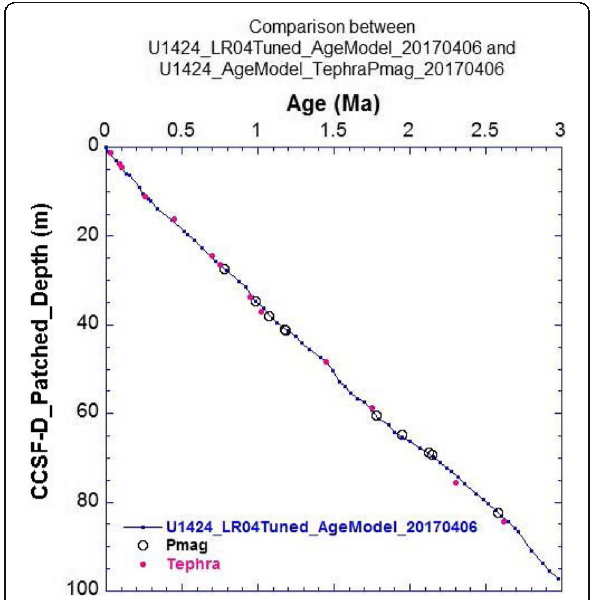
Fig. 3 A diagram showing age versus depth relationship at Site 1424 based on tuning of GRA and NGR profile at U1424 and LR04 benthic δ 18 O record of Lisiecki and Raymo (2005). All tuned points fall in an age versus depth relationship based on marker tephras and magnetostratigraphic events within